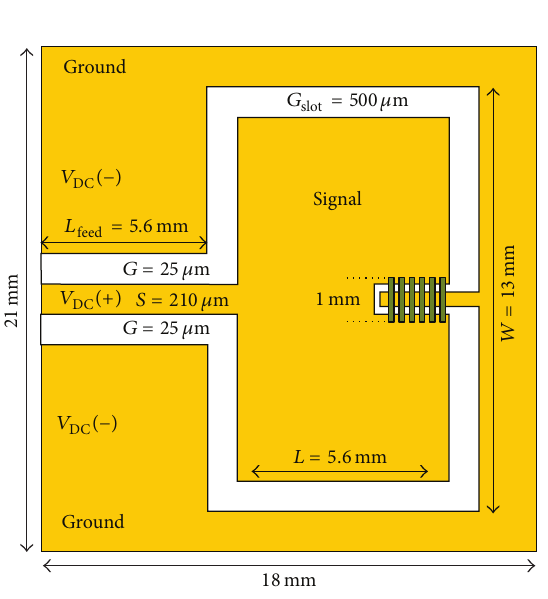
Figure 1: Slot-ring antenna loaded with MEMS